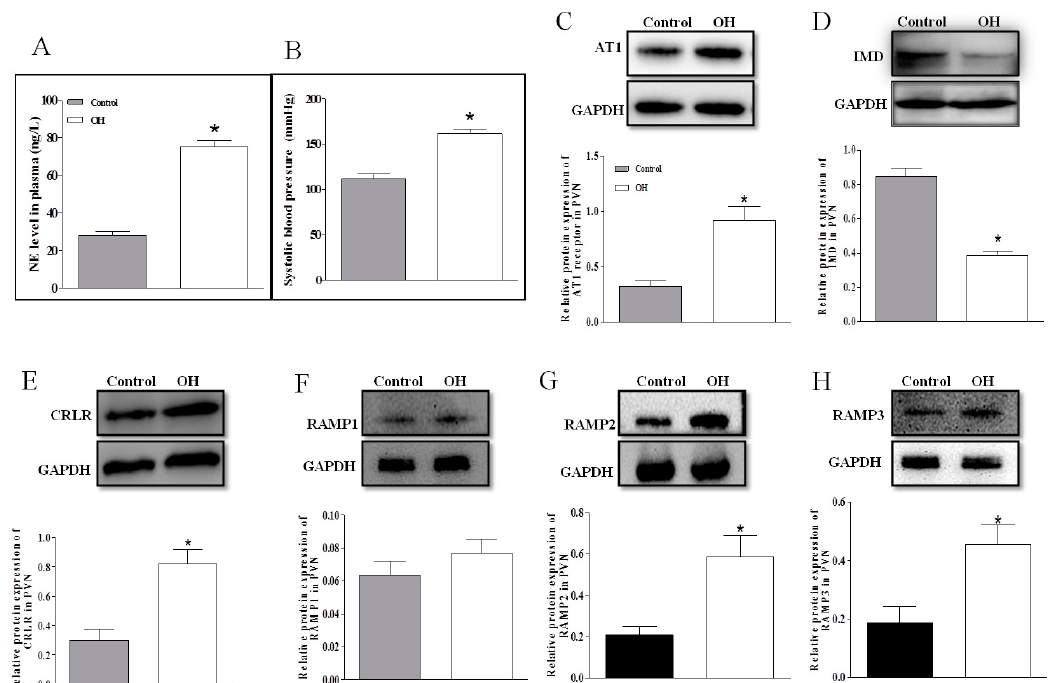
Figure 1. Plasma norepinephrine (NE) level ( A . n = 6 or 7), systolic blood pressure ( B . n = 6–7); and relative values of intermedin (IMD), calcitonin receptor–like receptor (CRLR) and receptor activity–modifying protein (RAMP) 1, RAMP2, and RAMP3 protein expression in the paraventricular nucleus (PVN) in control and obesity-related hypertensive (OH) rats ( C – H . n = 3–4). Values are mean ± SEM. * p < 0.05 versus control.